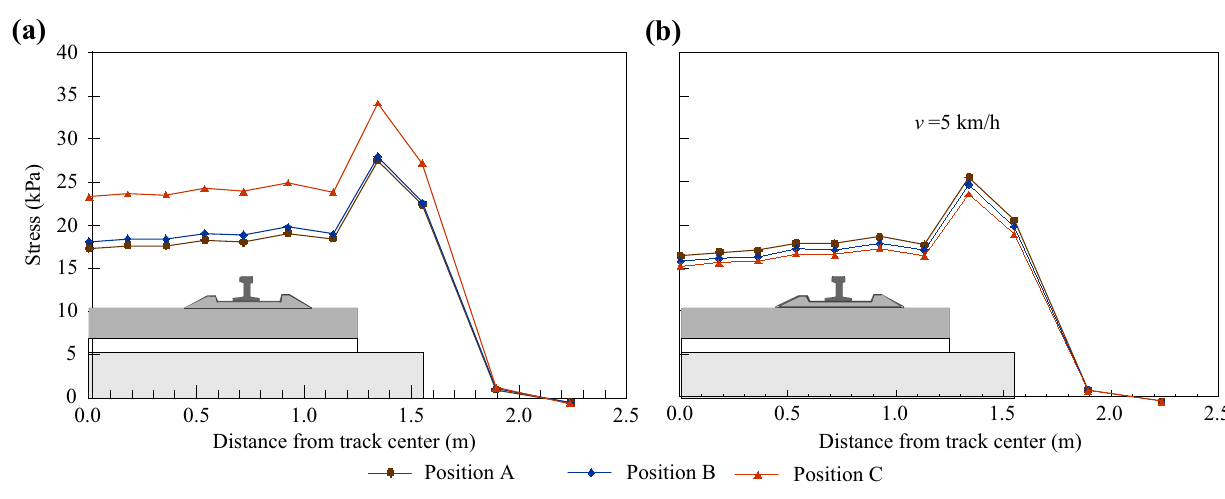
Fig. 7 Transverse distribution of stress on roadbed under double-axle load: a at center of bogie; b right under the action of axle load; positions A, B, and C can be found in Fig.